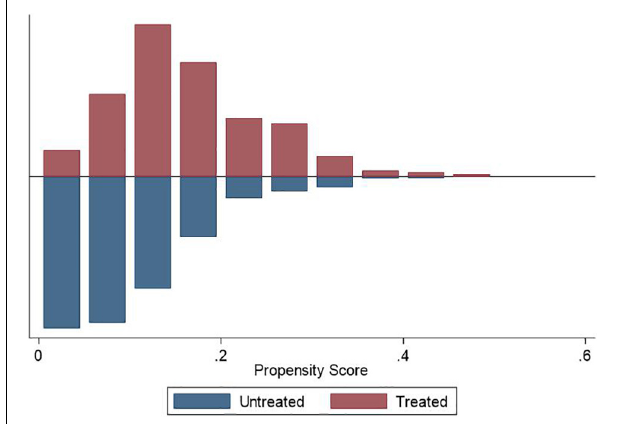
FIGURE 3 | Density distribution of treated and untreated observations (Fertility ≥ three